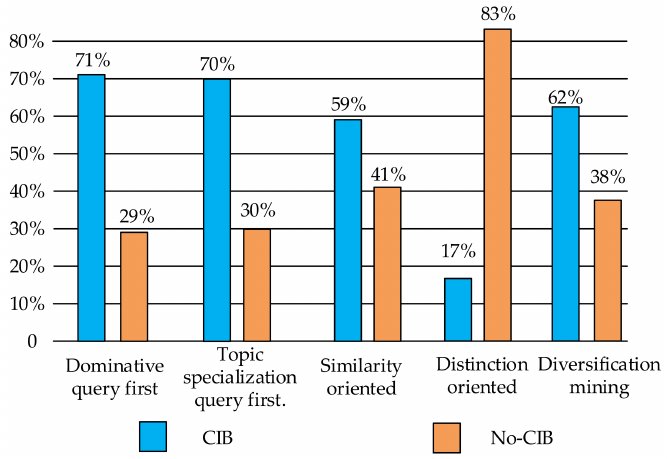
Figure 8. Distribution of CIB vs. no-CIB for each QCB